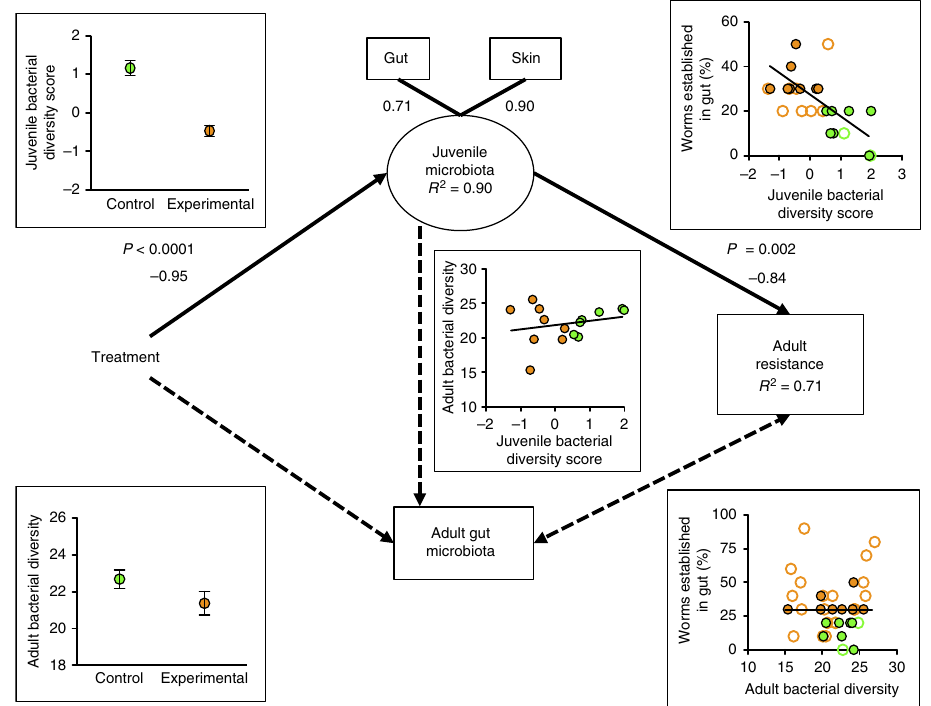
Fig. 5 Early-life disruption of juvenile skin and gut microbiota predicts later-life resistance to infection. Paths included in the best structural equation model (SEM) based on Akaike information criterion are depicted with solid lines ; paths not included in the best model are depicted with dotted lines . The best model shows that the experimental water treatment reduced bacterial phylogenetic diversity in juveniles, and in turn, bacterial diversity in juveniles negatively predicted worm establishment in the guts of adults. The best model combines gut and skin bacterial diversity of juveniles into a latent variable (because they are positively correlated; GLM, χ 2 = 31.95, df = 1, P < 0.0001) and therefore we use a factor score to present these data; numbers below the “ skin ” and “ gut ” boxes are factor loadings. In contrast, treatment did not affect bacterial diversity of adults, bacterial diversity of juveniles was not related signi fi cantly to bacterial diversity of adults, and bacterial diversity of adults was not related signi fi cantly to adult resistance to infection. The SEM only included tanks for which there was a complete set of samples for skin and gut bacteria of juveniles, gut bacteria of adults, and infection data ( n = 15; solid points ); clear points represent the remaining data. Control pond water treatment is represented in green and experimental water treatments (sterile pond water, sterile pond water plus antibiotics) are represented in orange . Individual regressions based on the entire available data set provide similar results as the SEM on the subset of complete data and thus we conservatively provide the results from only the subset. Error bars indicate the s.e.m. P -values and standardized coef fi cients from the best model are shown next to each path. R 2 -values indicate total variance explained by predictor variables in the top model. The χ 2 of the best model was 0.38 (df = 2, P = 0.83), indicating that the model was a good fi t to the data. This model accounted for 92% of